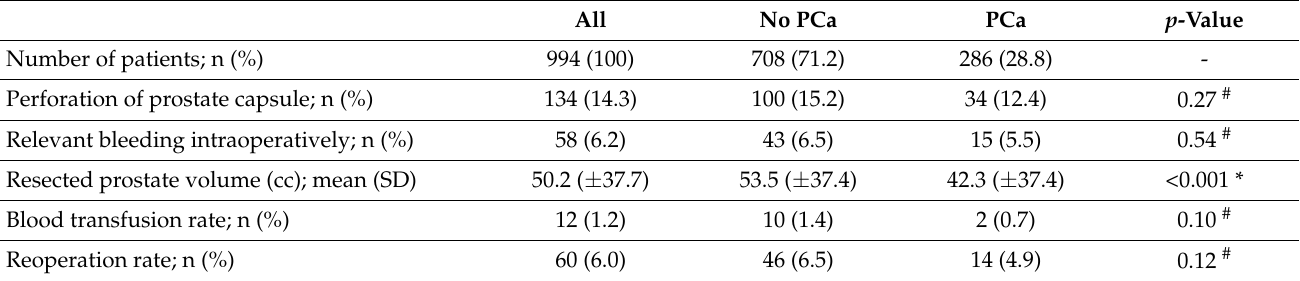
Table 2. Intra- and early postoperative characteristics of patients stratified by final